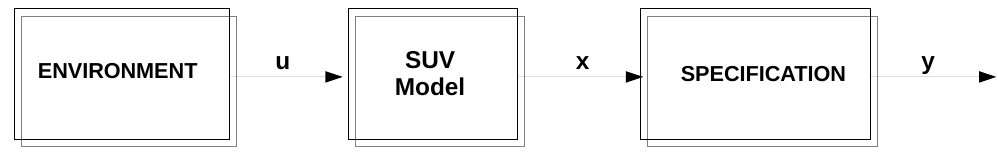
Figure 1. Simulation-based verification setting. Signal u models exogenous inputs, signal x models the SUV state, and signal y models the verification